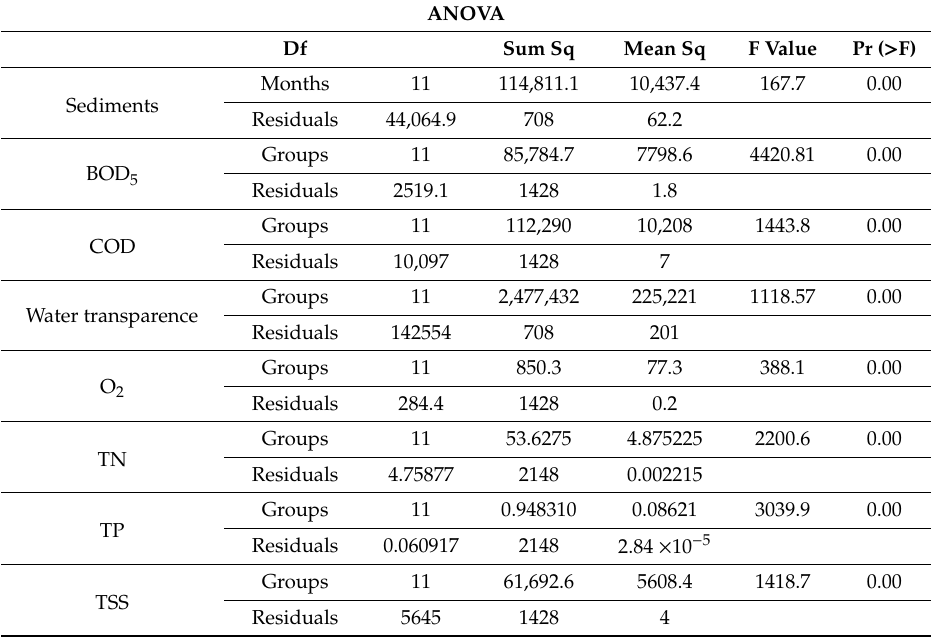
Table 4. Analysis of variance of selected parameters value in the period 2016–2018 (between